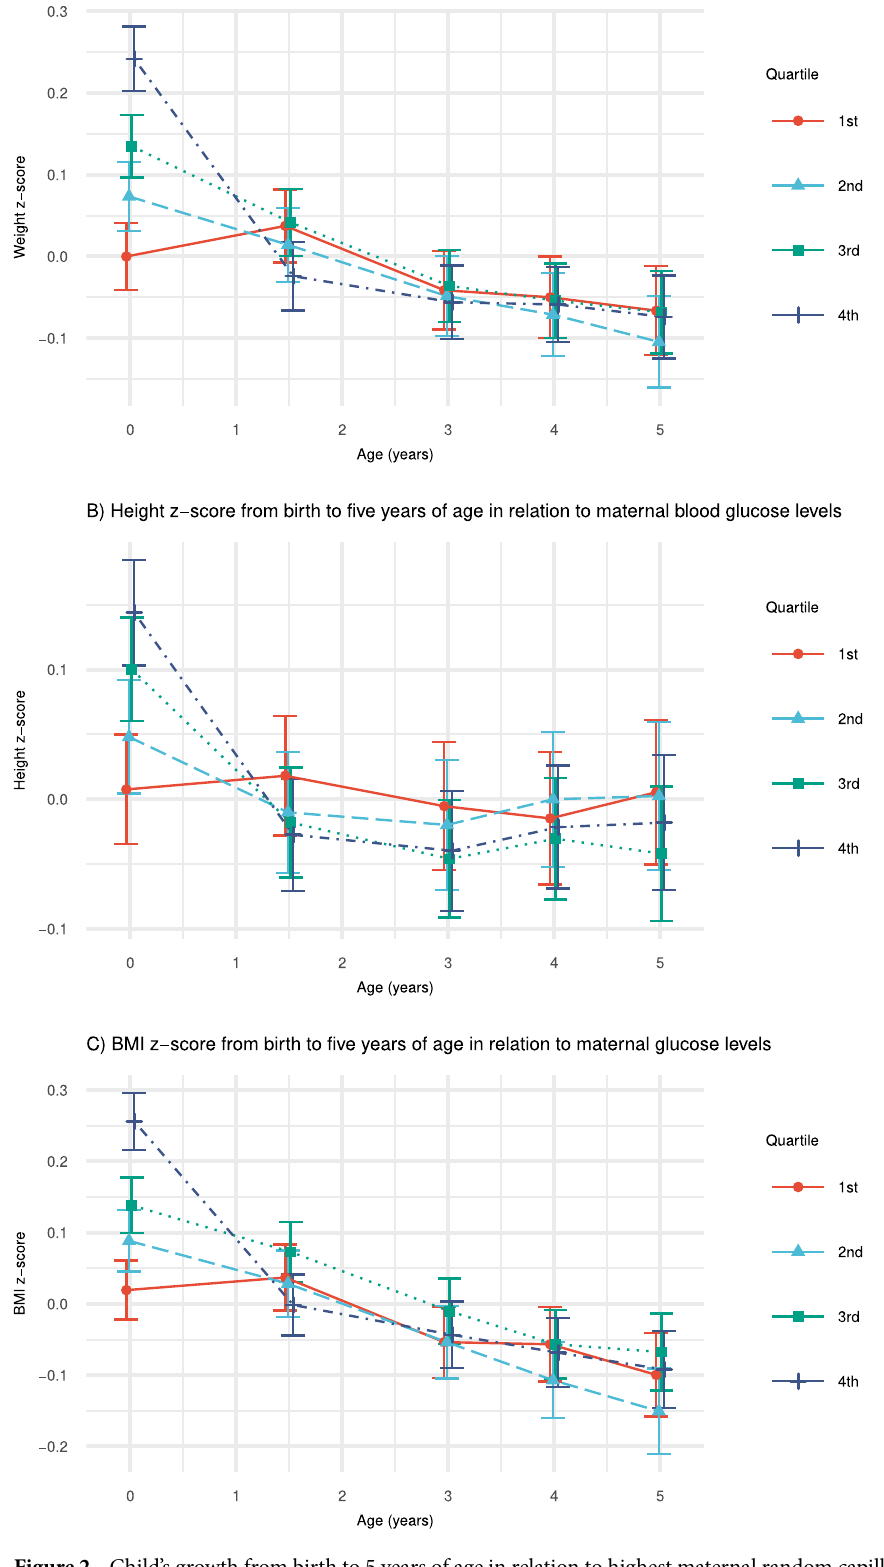
Figure 2. Child’s growth from birth to 5 years of age in relation to highest maternal random capillary blood glucose level during pregnancy. Analyses performed with linear mixed effect model with glucose divided into quartiles. (A) Child’s weight-z score, (B) height z-score and (C) BMI z-score from birth to 5 years of age in relation to highest maternal random capillary blood glucose level during pregnancy divided into quartiles. Bars represent 95% confidence